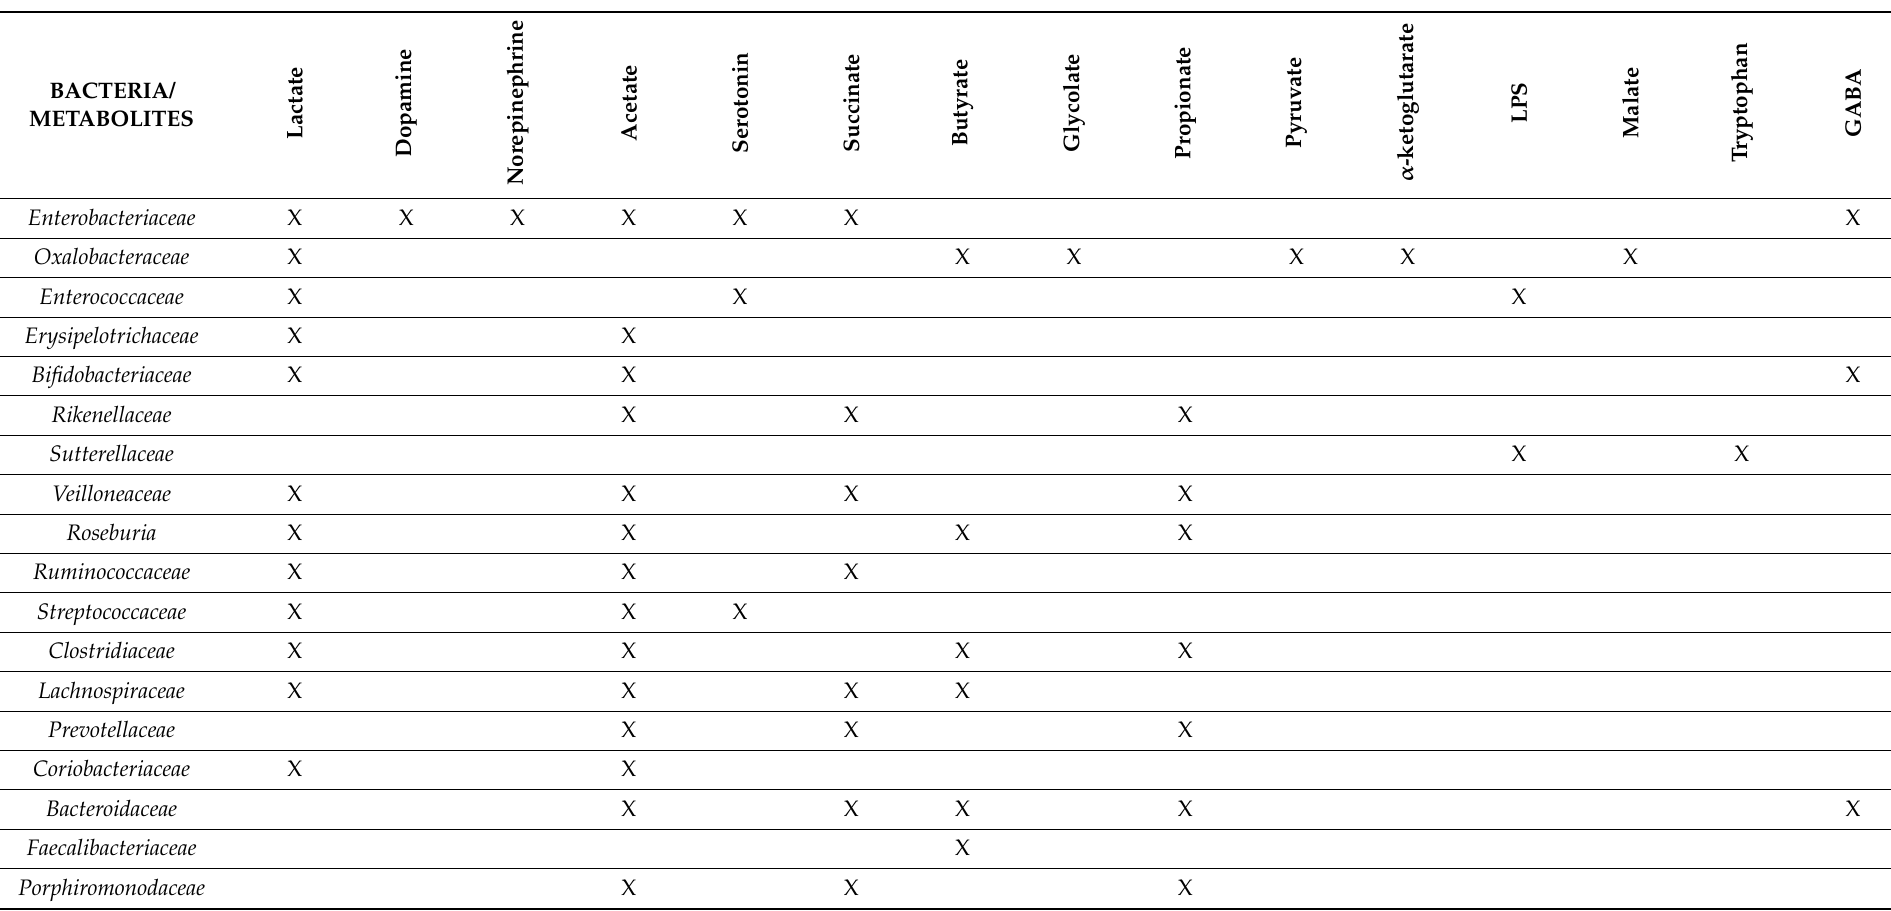
Table 3. Metabolites produced by altered microbiotas related to neural metabolism. Differentially expressed families and genera of analyzed microbiotas showed a production of metabolites acting as intermediates of neural